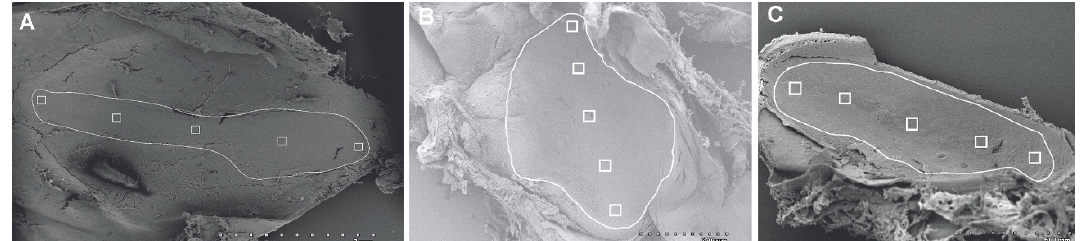
Figure 2. SEM. S. salar macula of saccule ( A ), utricle ( B ) and lagena ( C ). Hair cell bundle count locations on macula. Hair cell counts were sampled at five predetermined locations: 5, 25, 50, 75 and 95% of the total macular length. A 2500 µm 2 box was placed at each sampling area and hair cells were counted within each box. Scale bar ( A ) = 1 mm. ( B , C ) = 500 µm.